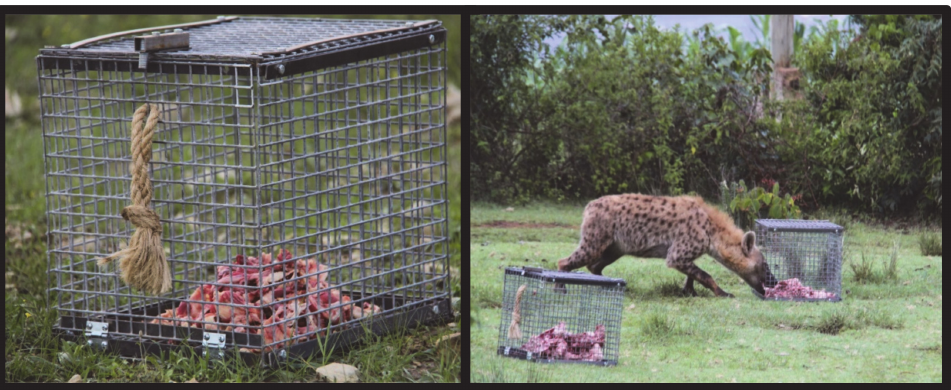
Figure 2. Newly baited puzzle box with door, showing the twisted knot handle that opens the door when pulled. Spotted hyena obtaining raw meat bait from puzzle box without door, with closed puzzle box in the